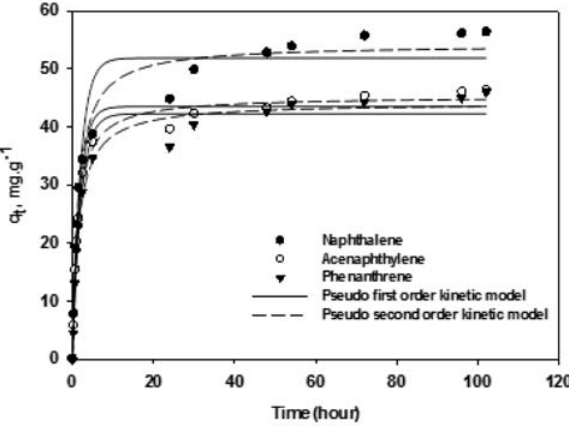
Fig. 7. Adsorption kinetics of NAP, ACN, and PHN on GO-9-AA at room temperature and pH